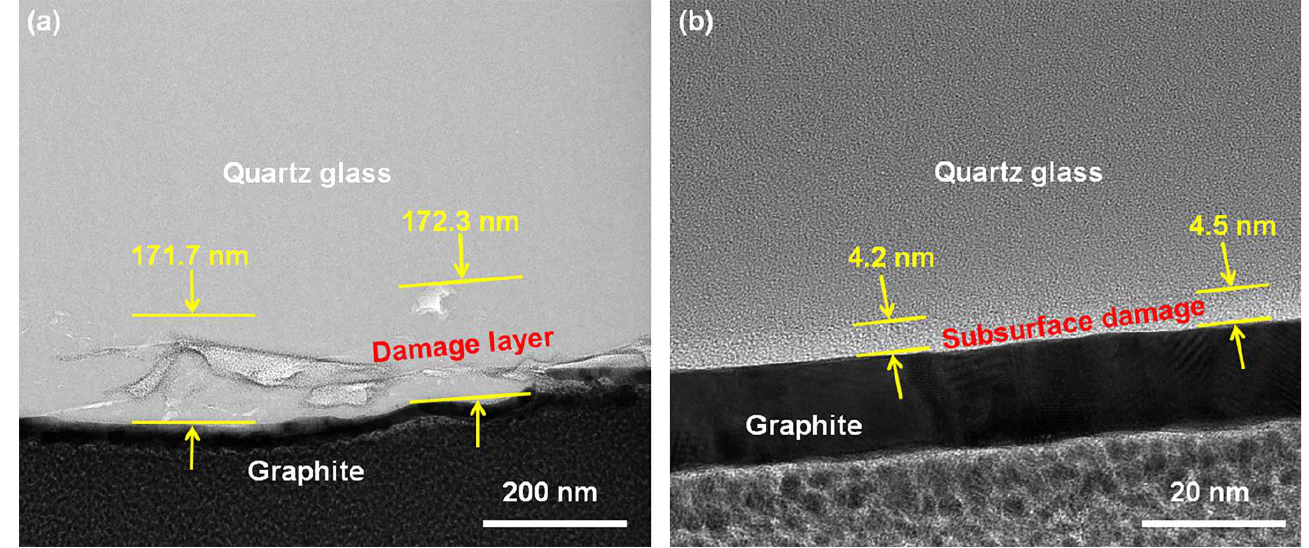
Figure 6. TEM cross-section of quartz glass ( a ) before polishing; ( b ) after polishing.